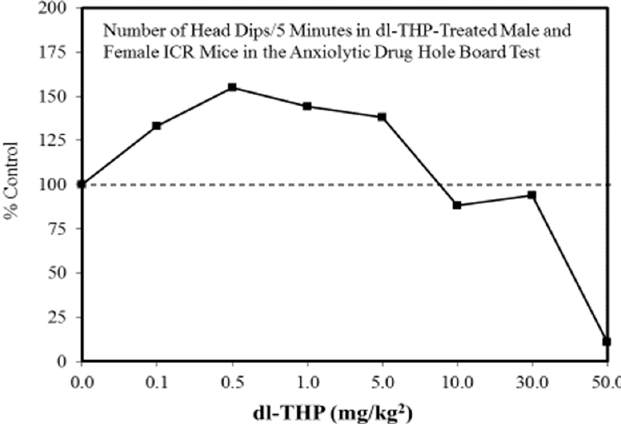
Figure 2. Number of head dips/5 min in (dl-THP)-treated male and female ICR mice in the anxiolytic drug hole board test (Source: Leung et al. [67]).